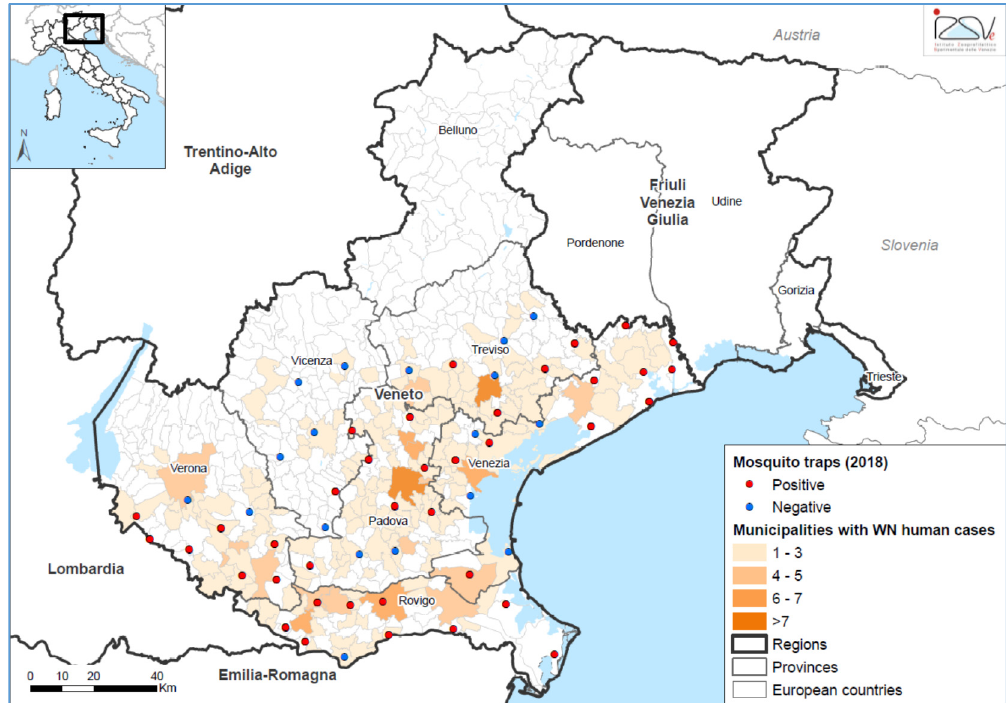
Figure 3. Geographical distribution of West Nile virus (WNV)-positive Culex mosquito pools and human cases of WNV infection, Veneto region, northern Italy, 2018. Sites of mosquito traps are represented with dots. Red dots indicate sites where WNV-positive mosquito pools were collected, blue dots indicate sites where no WNV-positive mosquitoes were detected. Colored areas represent municipalities where human cases of WNV infection were present.